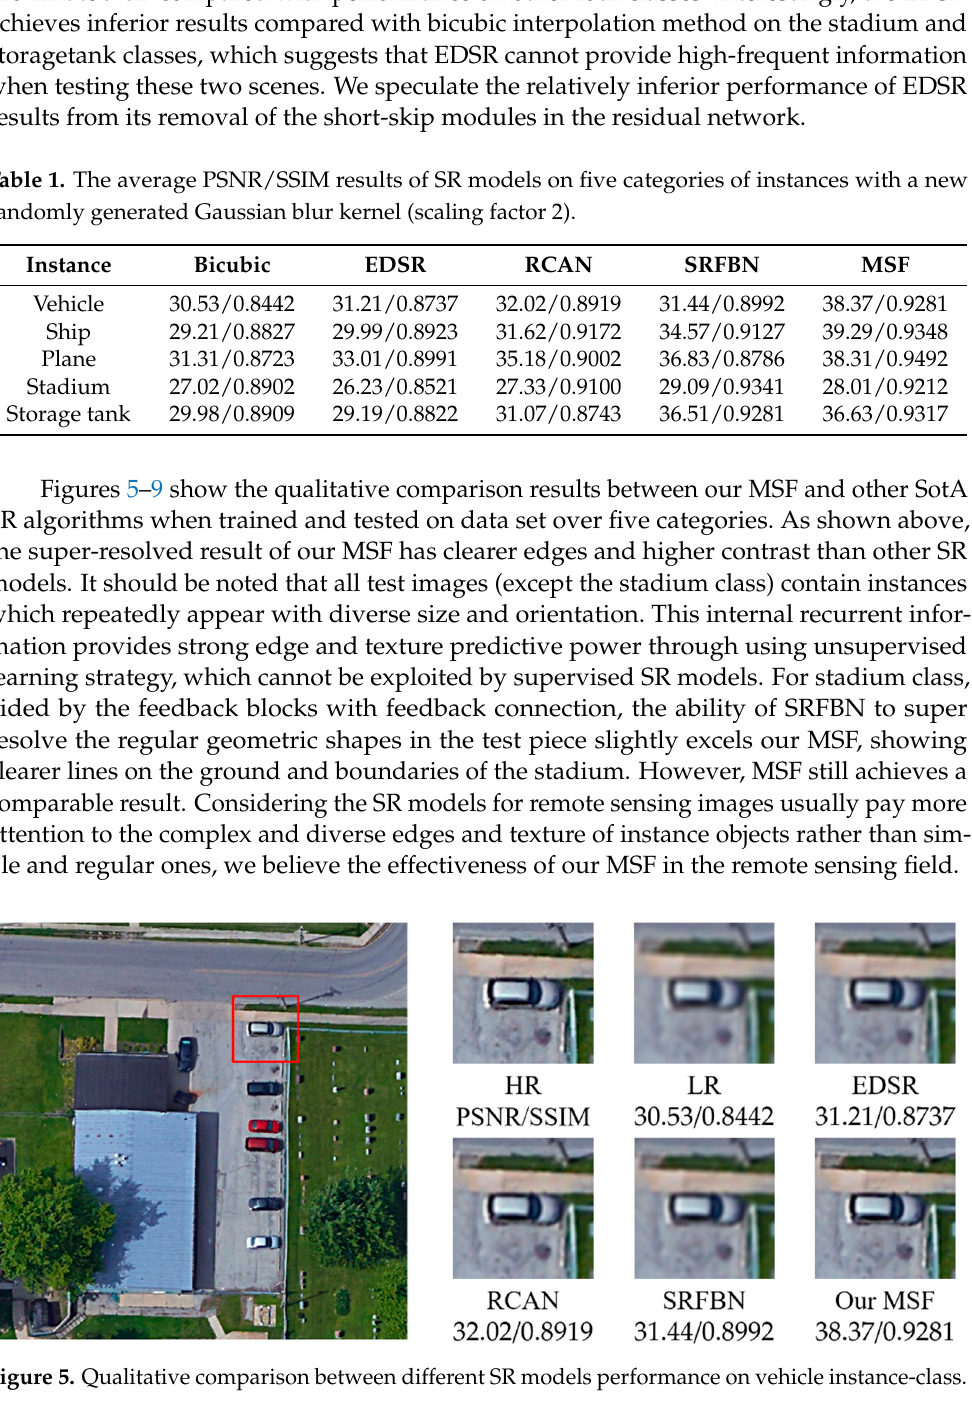
Figure 6. Qualitative comparison between different SR models performance on plane instance-class.